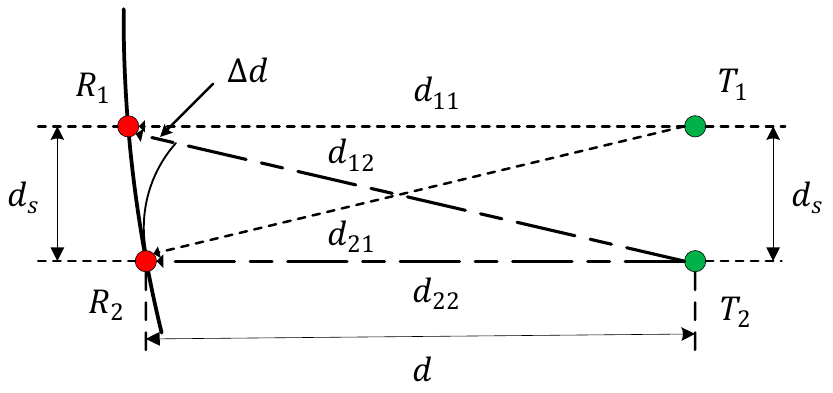
Figure 3. Circular arc 2 × 2 transceiver antenna array.